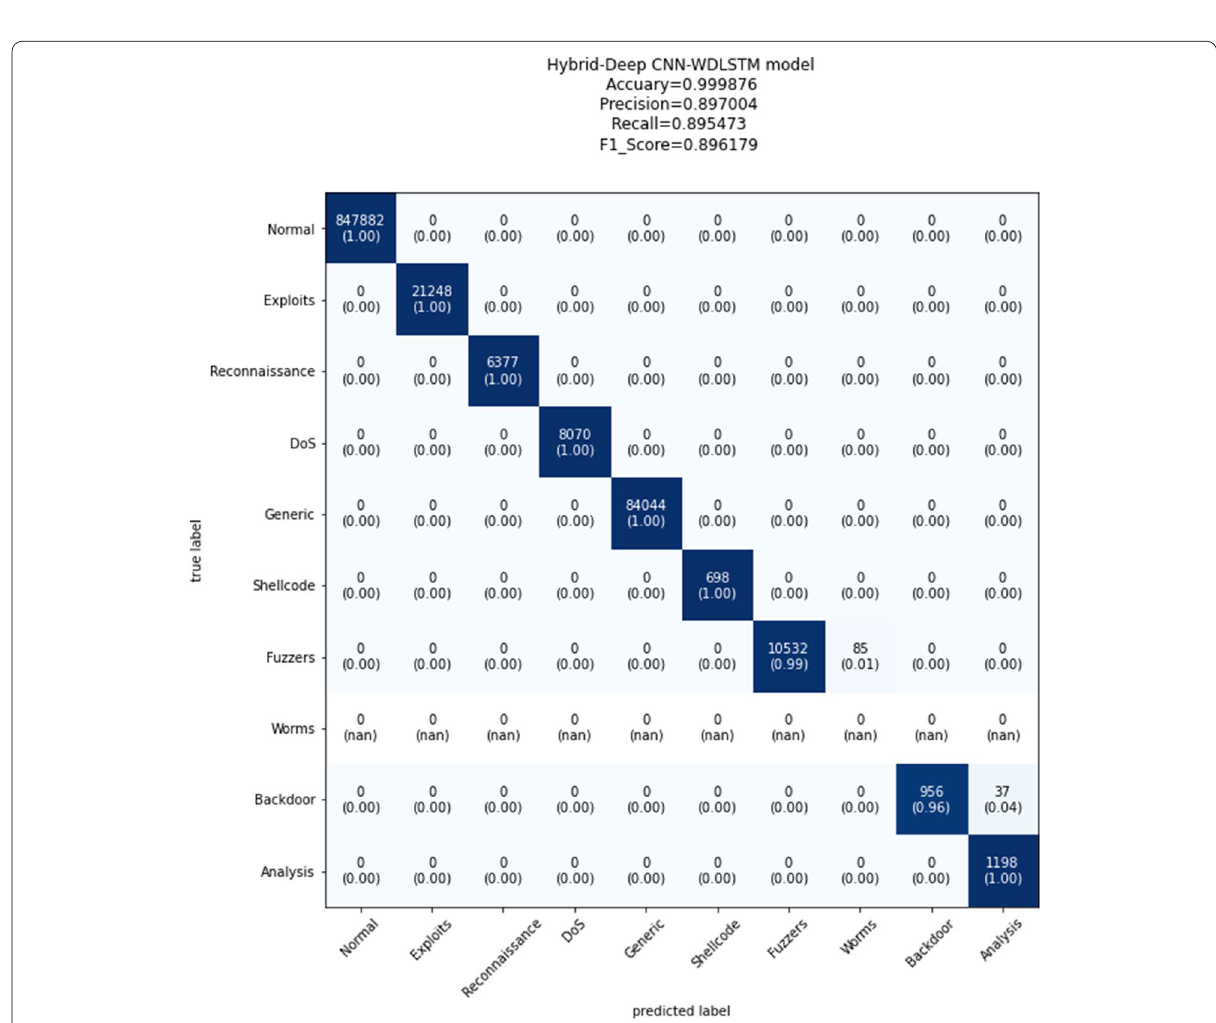
Fig. 6 Confusion Matrix of CNN-LSTM